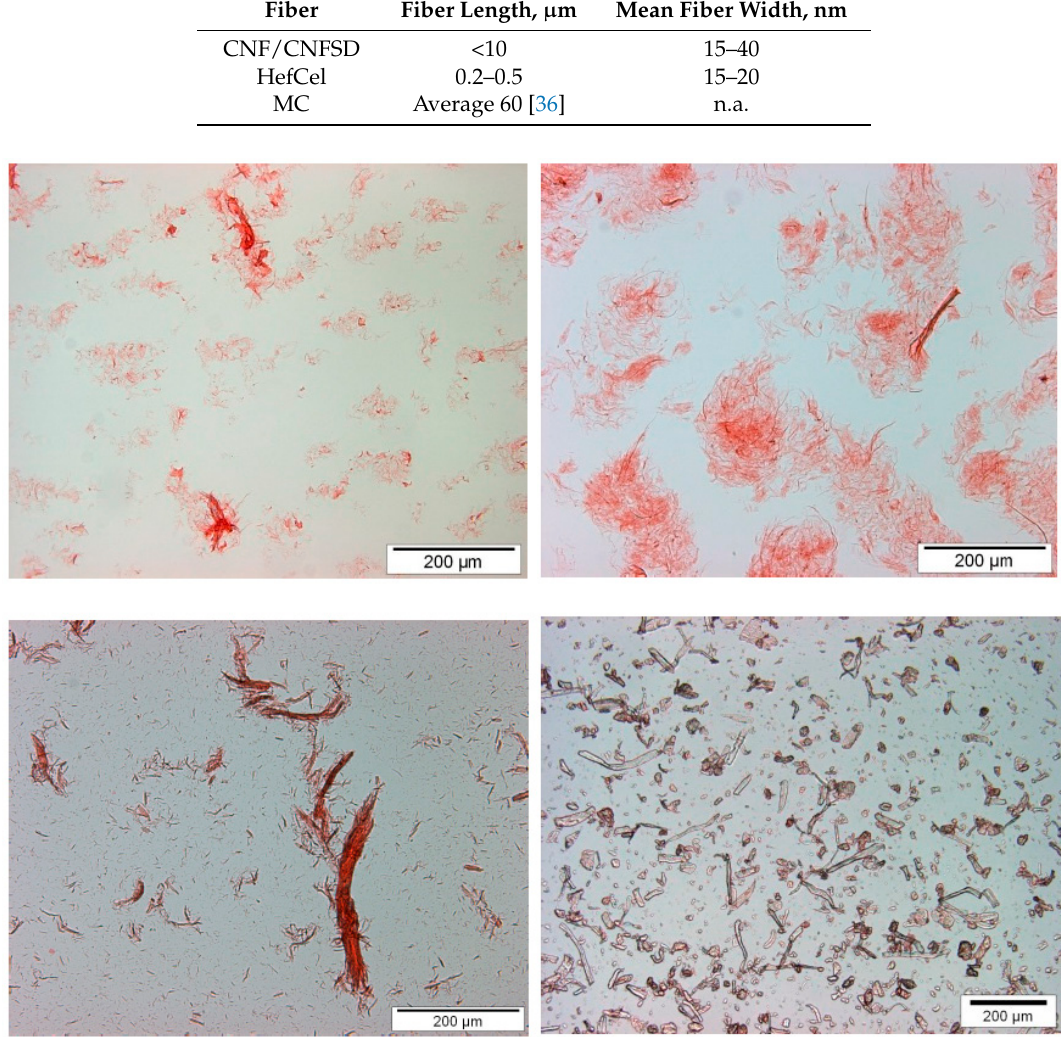
Figure 1. Images of fibrillated samples. CNF made of dissolving pulp CNFSD ( upper left ), kraft pulp Figure 1 . Images of fibrillated samples. CNF made of dissolving pulp CNFSD (upper left), kraft pulp CNF ( upper right ), HefCel CNF ( lower left ) and microfiber MC ( lower right CNF (upper right), HefCel CNF (lower left) and microfiber MC (lower right).